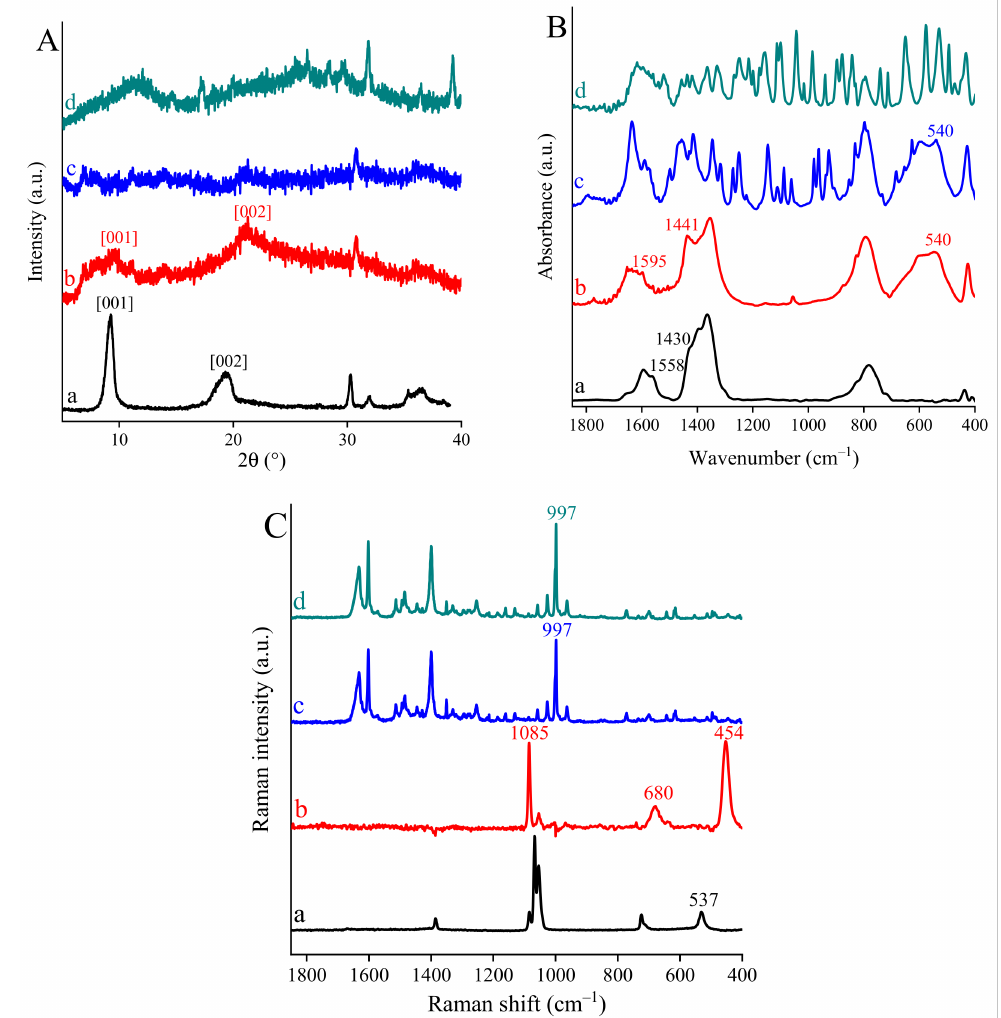
Figure 2. XRD patterns ( A ), IR ( B ) and Raman ( C ) spectra of CaAl–cysteinate–LDH (a) and CaAl– cysteinate–LDH (0.1 g) oxidized by 0.4 M of peracetic acid (b), bromine (c) or H 2 O 2 (d) suspended in water (100 cm 3 ) at 298 K. The reaction time was 60